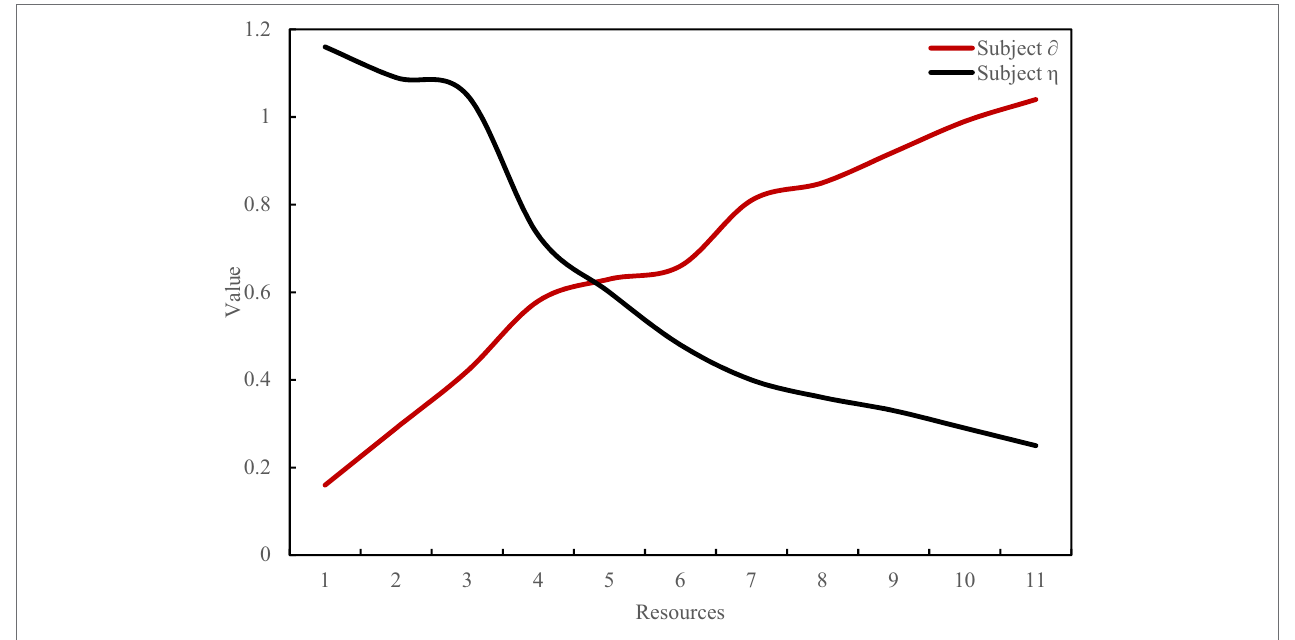
FIGURE 4 | Changes in the exchange volume of collaborative innovation